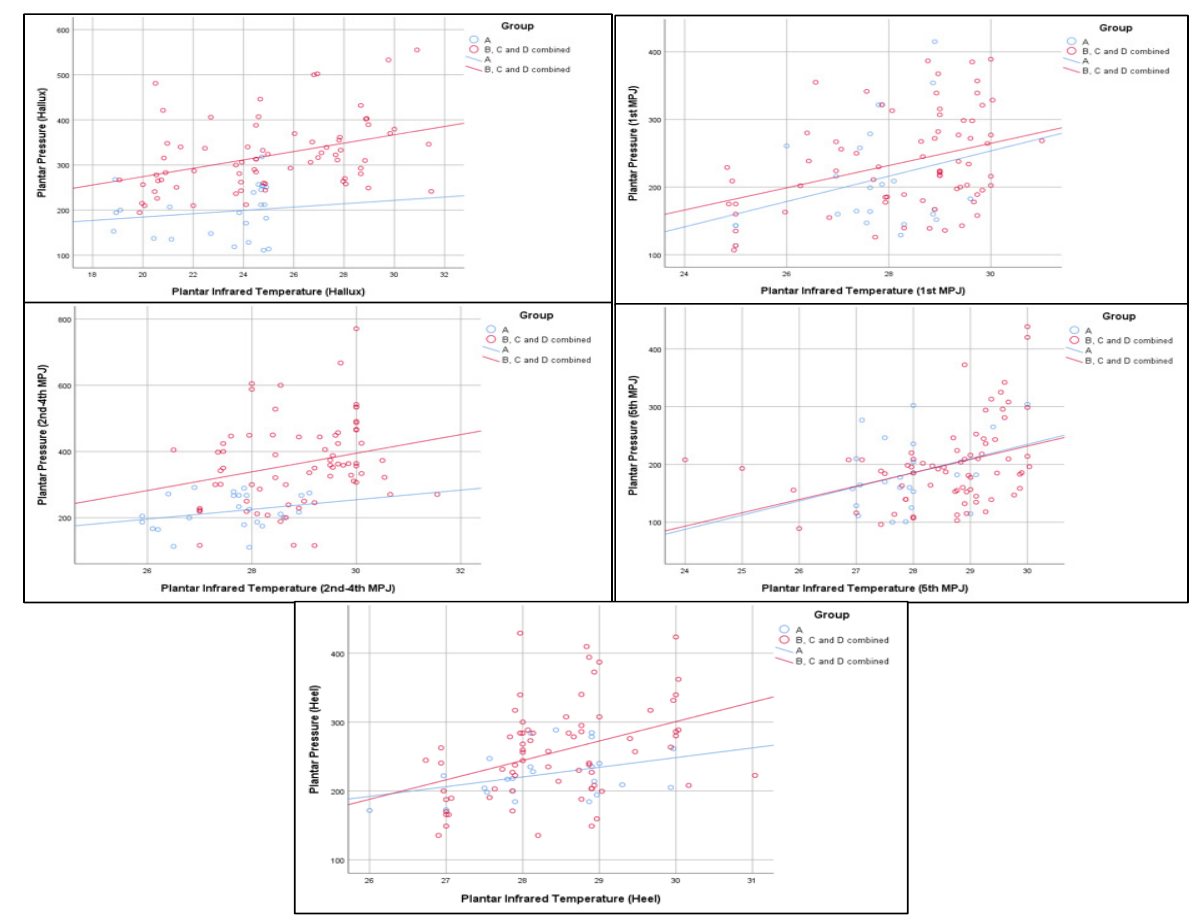
Figure 6. Scatter plot displaying the relation between plantar pressure and plantar infrared temperature in the regions of interest.